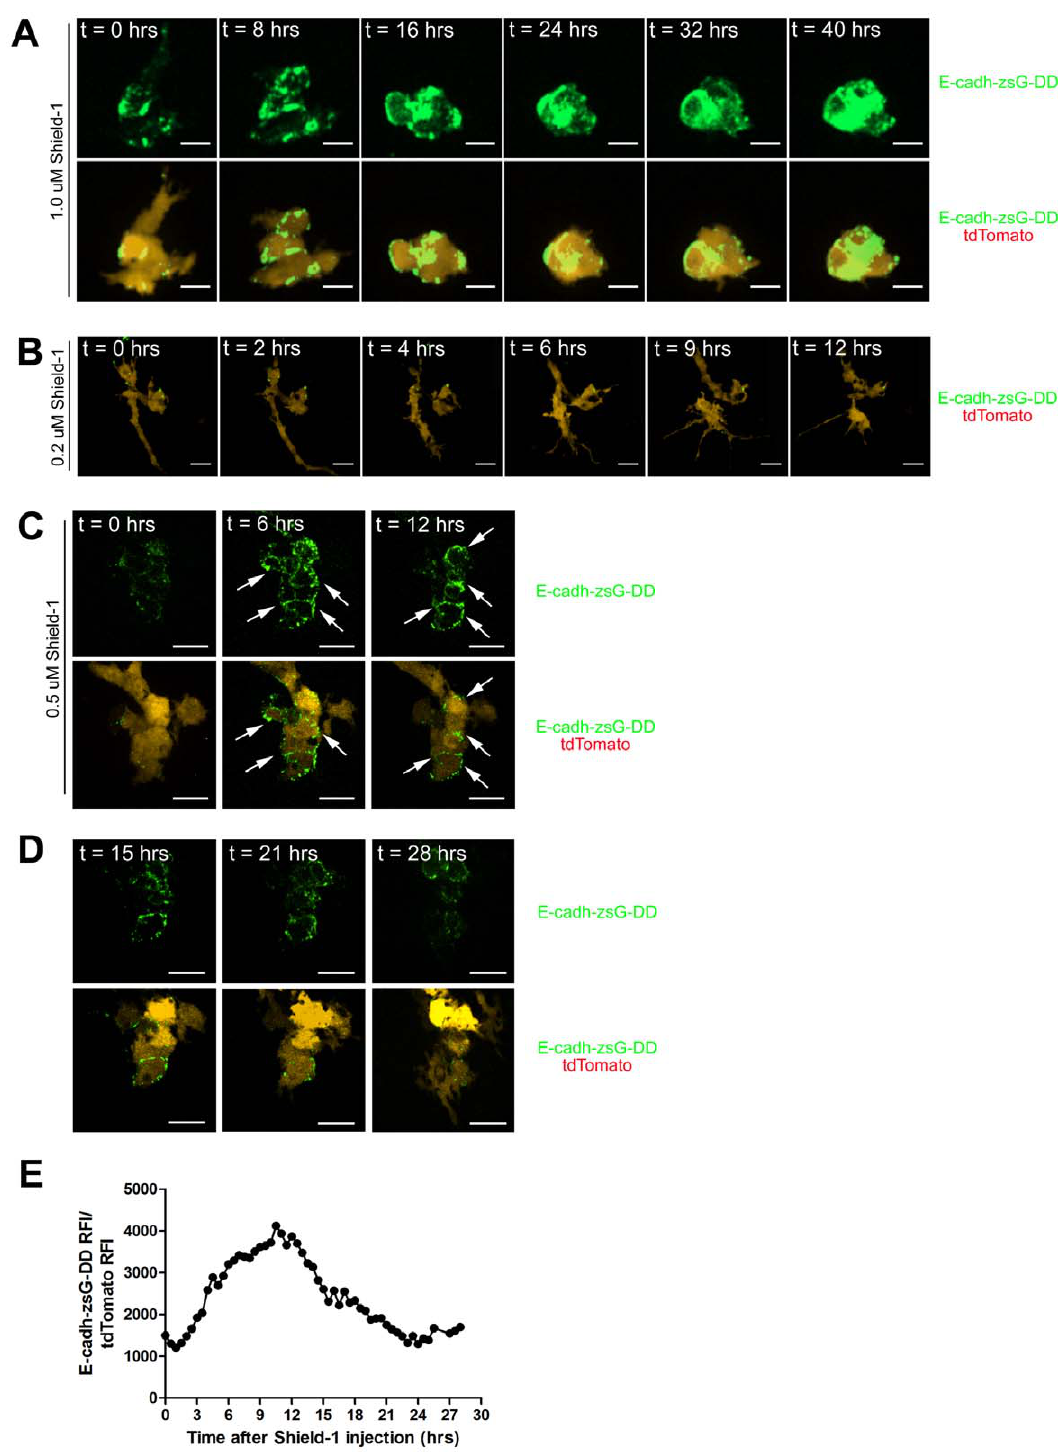
Figure 7. Induction of E-cadherin causes morphological changes in 231LN micrometastases. 231LN cells expressing tdTomato (red) and tunable E-cadherin-zsGreen-DD (green) were injected intravenously in the avian embryo and allowed to extravasate and proliferate into micrometastases. Representative maximum intensity projections are shown. A) In vivo treatment with 1.0 m M Shield-1 demonstrates transition from a mesenchymal morphology to an epithelial morphology and continued maintenance of the epithelial morphology over an extended period of time ( . 40 hrs). Formation of E-cadherin junctions is apparent at t=0.5 hrs, increasing through 24 hrs. B) Representative micrometastatic colony expressing tunable E-cadherin-zsG-DD and treated with 0.2 m M Shield-1. No induction effect is observed with 0.2 m M Shield-1 in vivo . C) Single Z- plane slices of a representative micrometastastic colony expressing tunable E-cadherin-zsG-DD and treated with 0.5 m M Shield-1. These panels represent the stabilization effect induced by 0.5 m M Shield-1 over the 12 hour time course; E-cadh-zsG-DD is stabilized and junctions appear between 231LN cells. E-cadh-zsG-DD junctions between cells of the micrometastatic colony are highlighted by arrows. D) Panels represent the depletion effect